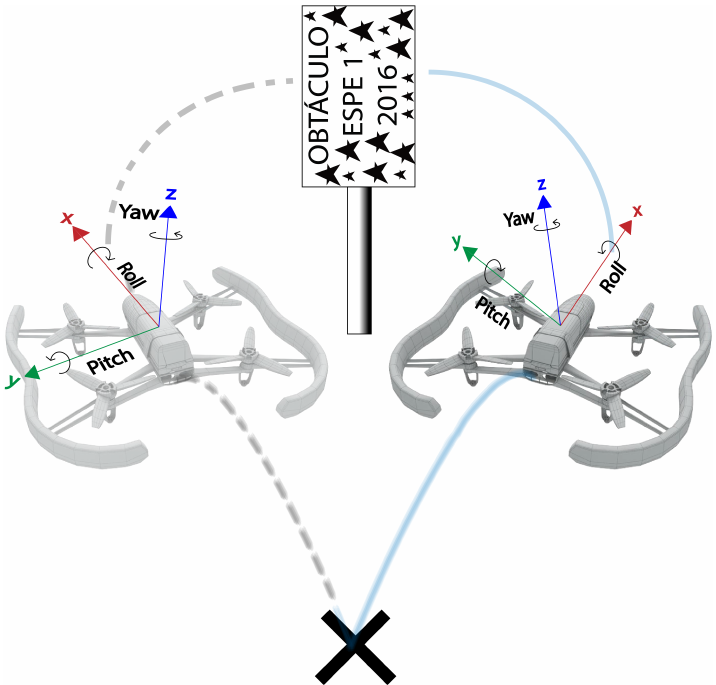
Figure 9. Control action with an obstacle inside of the path. The system can avoid the obstacle with a displacement on the y